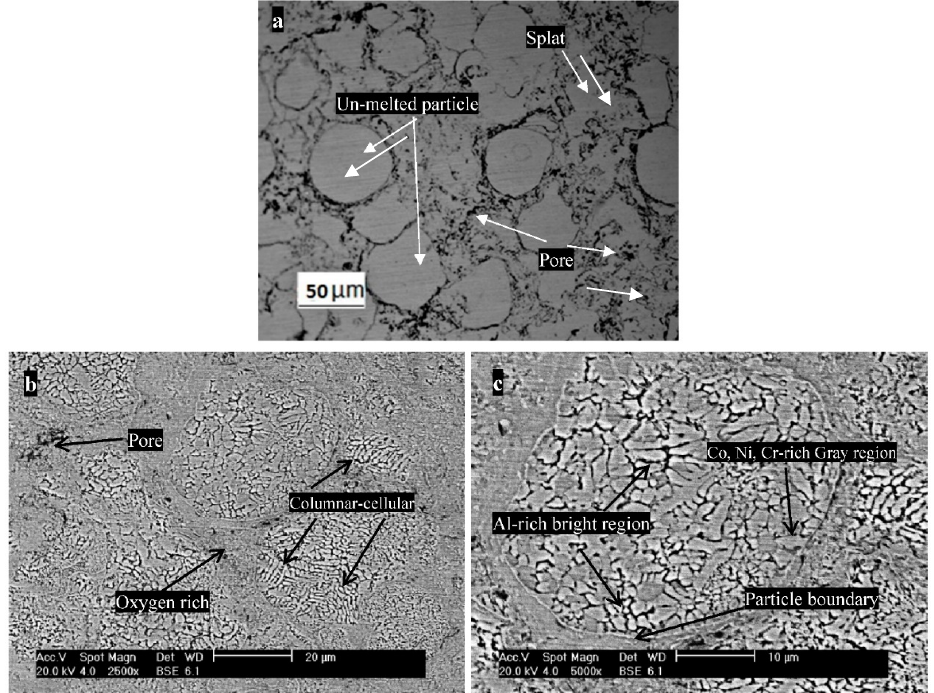
Figure 4. ( a ) Micrograph of CoNiCrAlY coating, ( b ) SEM images of CoNiCrAlY coatings, ( a ) at 2500×, and ( c ) at 5000×. and ( c ) at 5000 ×